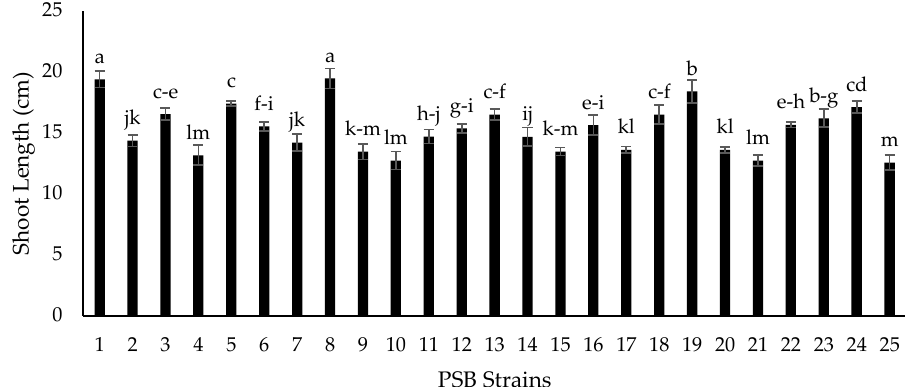
Figure 5. E ff ect of phosphate solubilizing bacteria (PSB) strains on chickpea shoot length (cm). Strains (1–24) are phosphate solubilizers (RP-01 to RP-24) while 25 is the control treatment. The bars indicate standard error ( ± SE) of the mean ( n = 3). Means followed by the same letter within the bars are not significantly di ff erent at p = 0.05